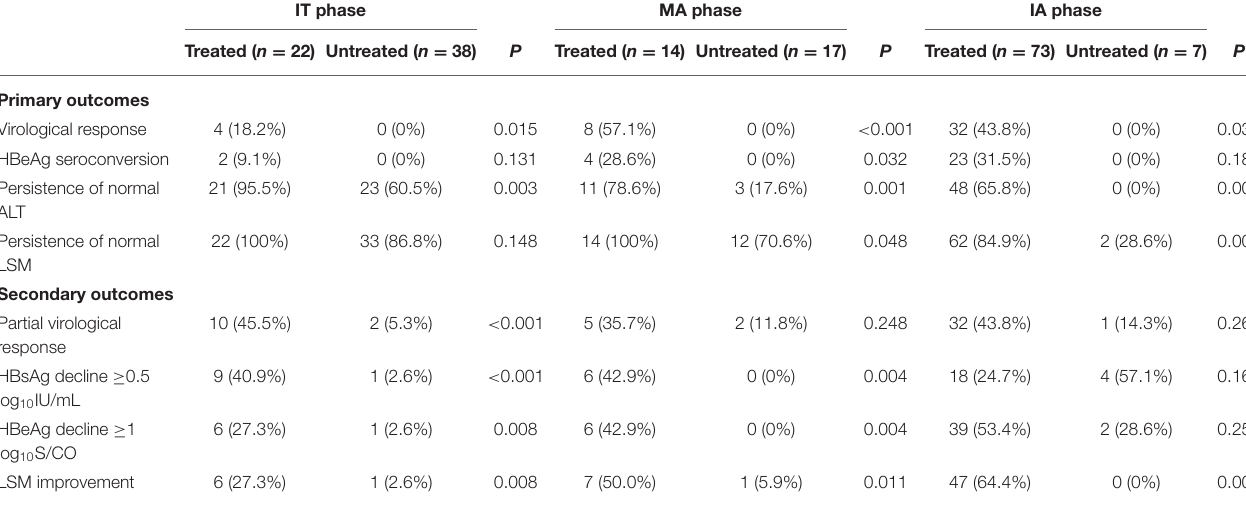
TABLE 2 | Efficacy endpoints in liver biopsy-proven IT, MA, and IA-phase patients. IT phase MA phase IA phase